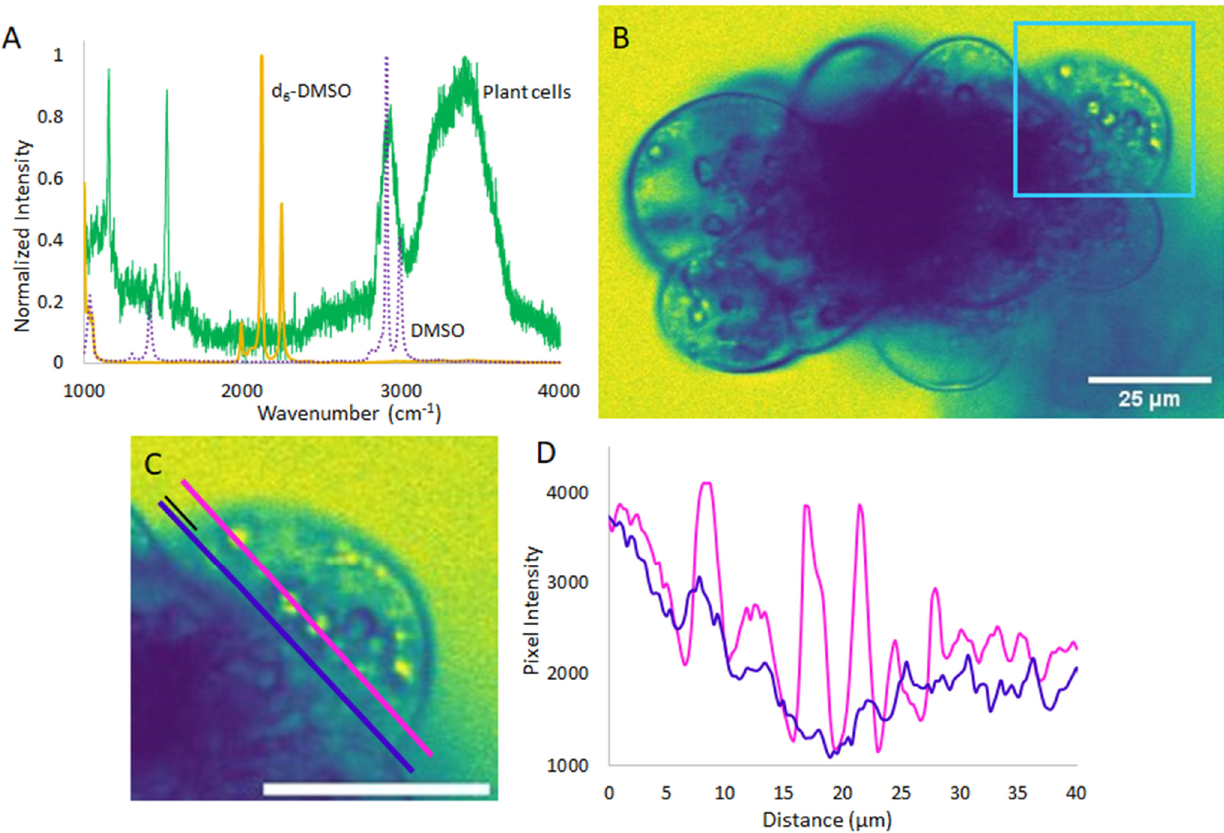
Figure 2. ( A ): Spontaneous Raman spectra of d 6 -DMSO (yellow), DMSO (purple, dashed), and the rice cells (green), showing the shift in DMSO vibrational frequency upon deuteration away from significant peaks in the cell spectrum. ( B ): Representative CARS microscopy image of rice cells imaged in resonance with the d 6 -DMSO stretching vibrational mode (yellow trace in A ). Signal from d 6 -DMSO appears yellow while places blocking the d 6 -DMSO signal appear blue. ( C ): Expanded view of cell outlined in light blue in B. Parallel pink and dark blue line profiles bisect three organelles and the relatively uniform space away from organelles, respectively. Both lines start 5 µ m outside of the cell, a distance shown with the small black line, and stretch, parallel, across approximately 40 µ m. ( D ): Pixel intensity along pink and dark blue line profiles from C as a function of distance along the line. Scale bars in C and D are 25 µ m. Images artificially colored with ImageJ LUT, mpl-viridis